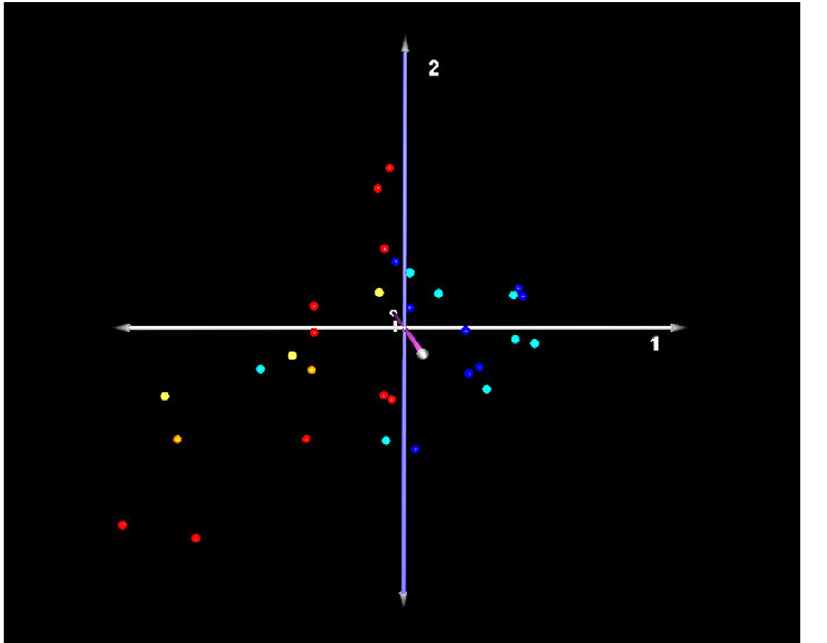
Figure 3. Principal component analysis of IPF samples grouped by extent of disease correlated with D L CO % predicted (mild $ 65%, severe # 35%). Red spheres: definite IPF; Orange spheres: probable IPF; Yellow spheres: unclassifiable fibrosis;Blue spheres: mild IPF; Green spheres: severe cases of IPF. Axis labels: white-first principal component; blue-second principal component; lavender- third principal component. doi:10.1371/journal.pone.0037708.g003 PLoS ONE |